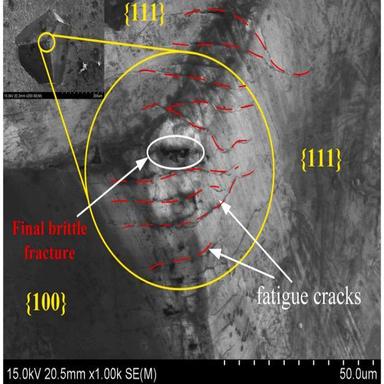
Fatigue cracks at the intersection of and crystal planes.